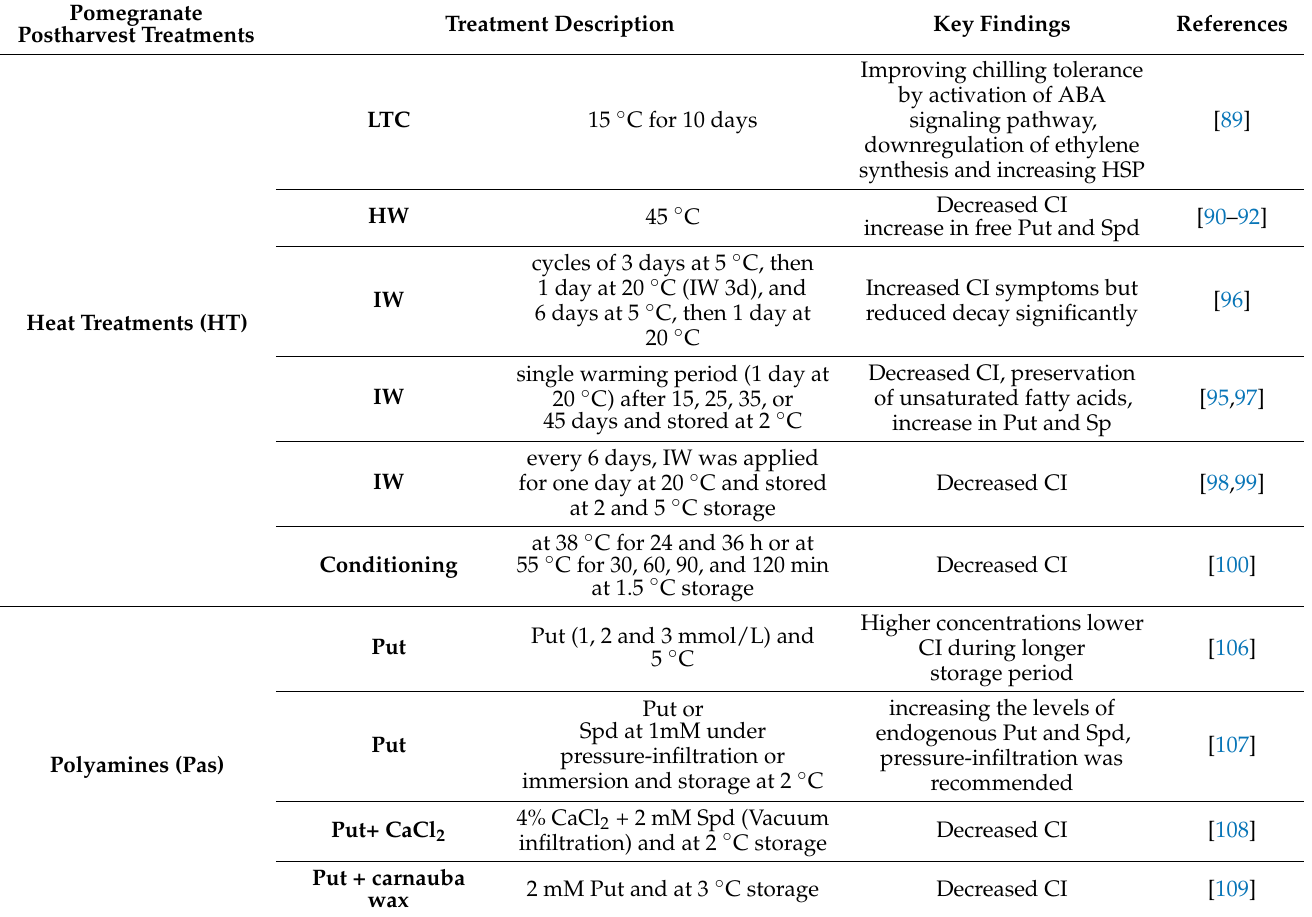
Summary of postharvest treatments applied to prevent CI in pomegranate fruit during